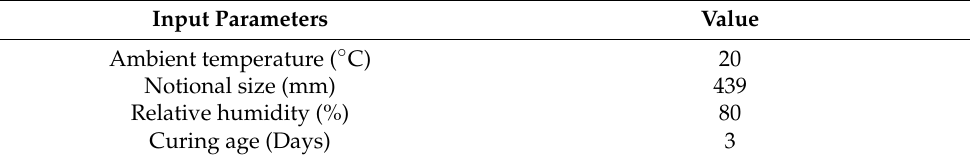
Table 4. Input parameter for Euro-code 2 EN 1992-1-1 creep and shrinkage